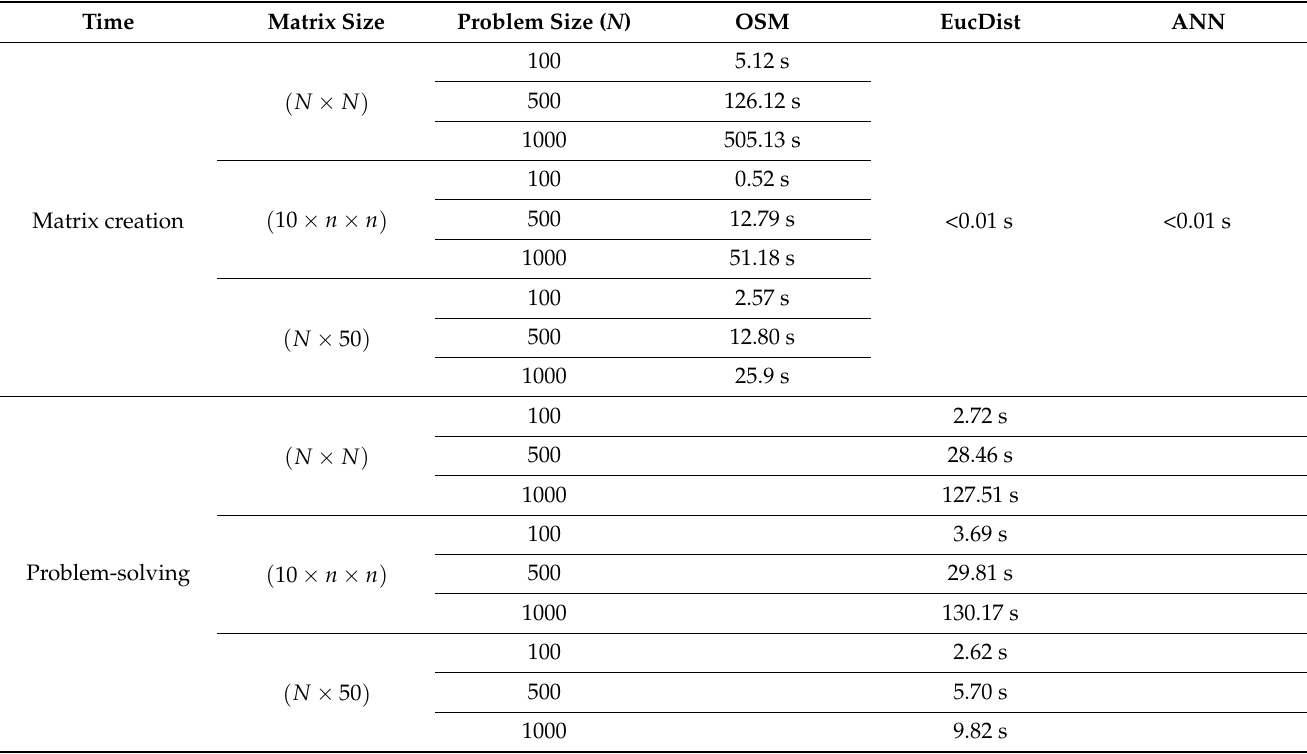
Table 5. Average matrix creation time and problem-solving time from experimental